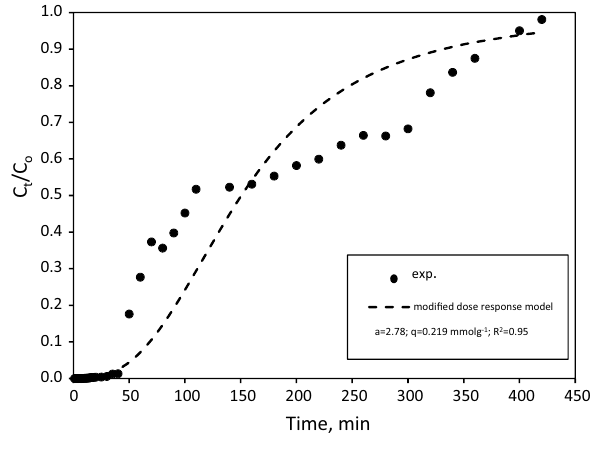
Fig. 7 Breakthrough curve for Pb 2+ adsorption (bed height = 5 cm; flow rate of 1 mL min −1 ; initial concentration = 0.5 mM; particle size = 0.6 mm; pH